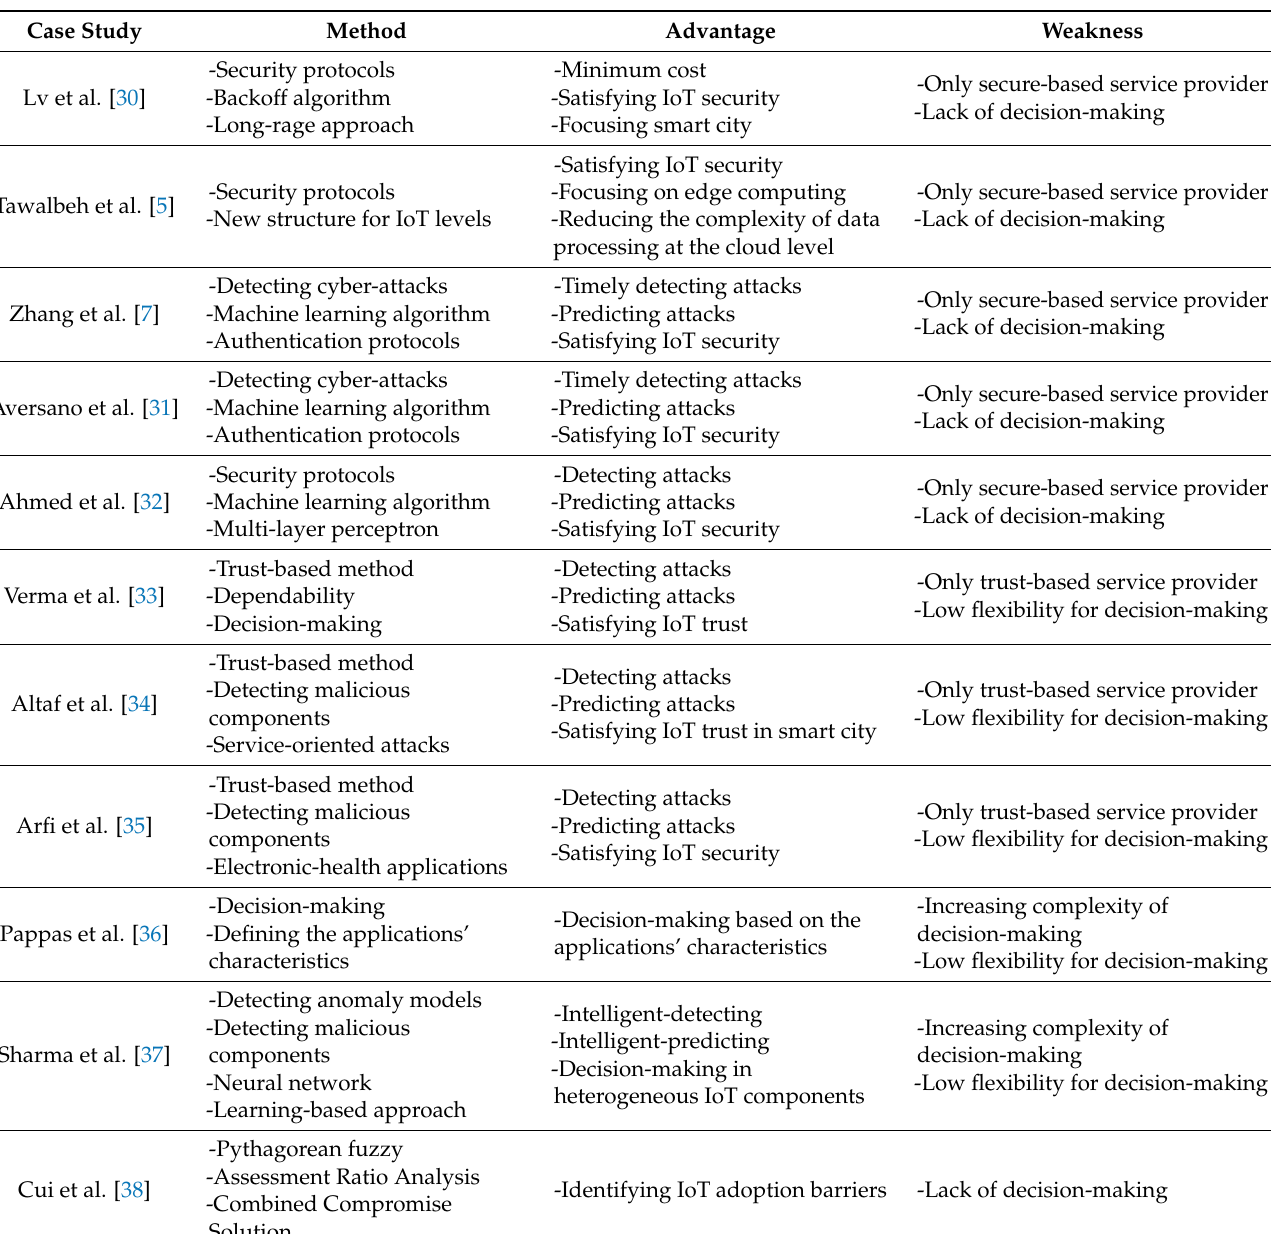
Table 1. Reviewing the existing works and comparing their characteristics